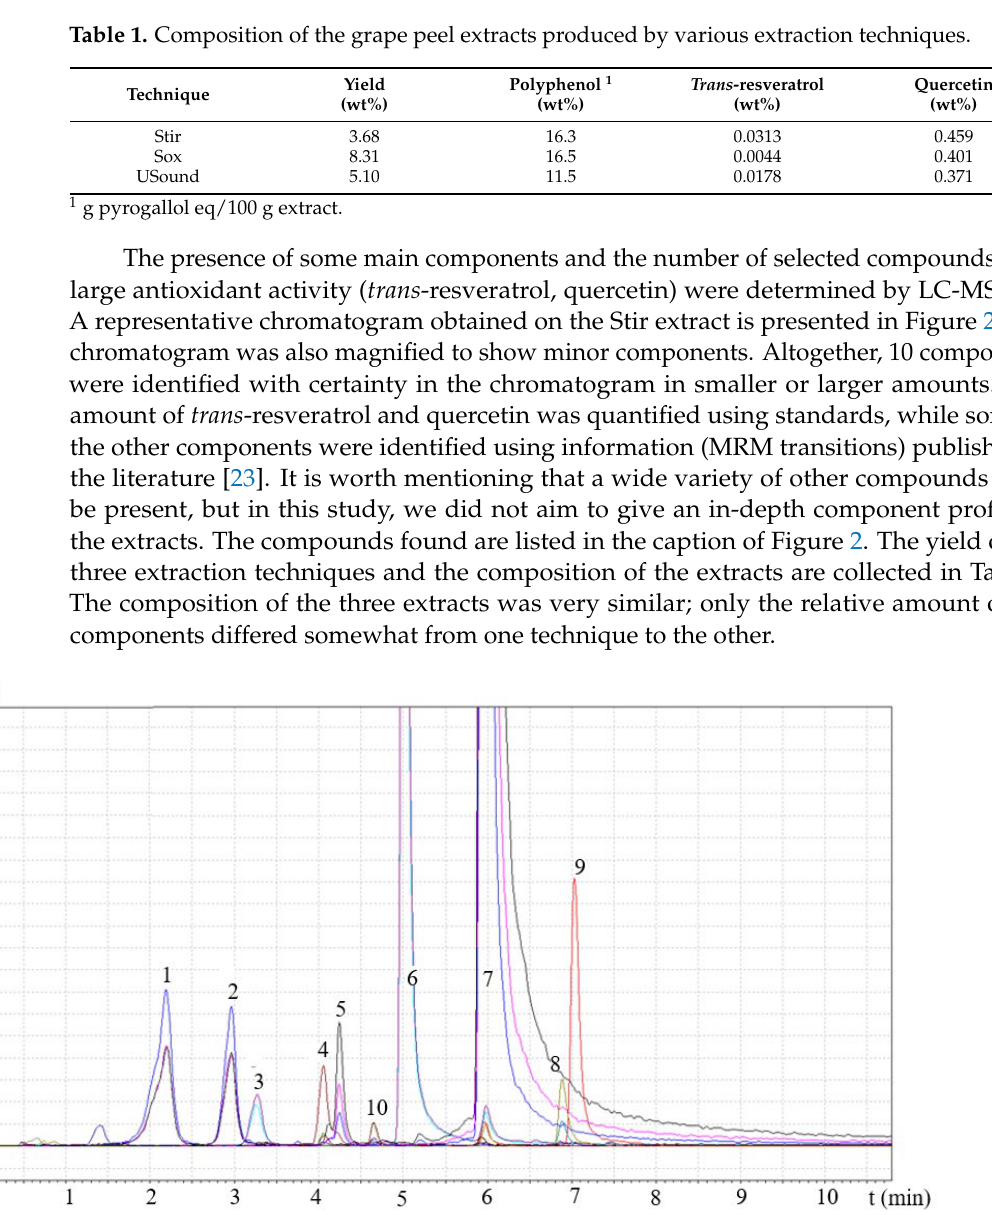
Figure 2. LC-MS/MS analysis of the composition of grape peel extract obtained by Soxhlet extraction. Different colors indicate different MRM transitions of the main components: (1) catechin, (2) epicatechin, (3) myricetin glycoside, (4) epicatechin gallate, (5) quercetin glycoside, (6) myricetin, (7) quercetin, (8) kaempferol, (9) isorhamnetin and (10) trans -resveratrol.